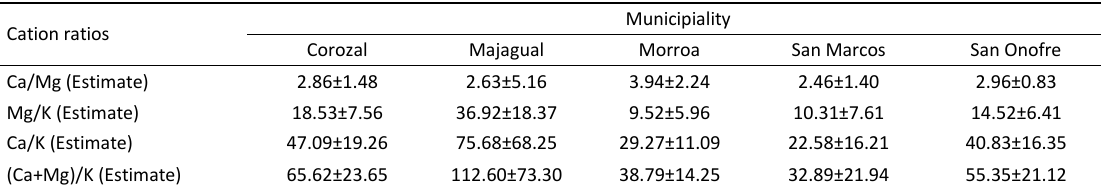
Table 5: Summary of the calculated cation ratios by the municipality.